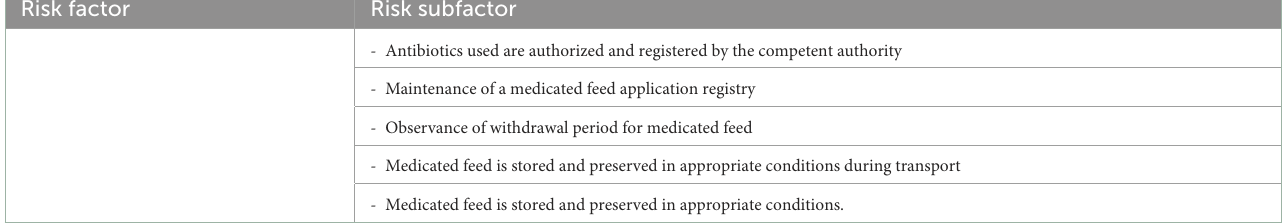
TABLE 2 AMR exposure risk factors and subfactors for animal health. Risk